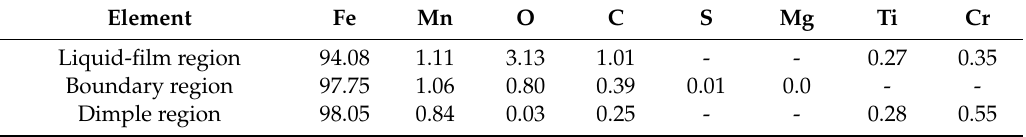
Table 2. Elemental compositions of the crack surface at di ff erent regions (wt. %).